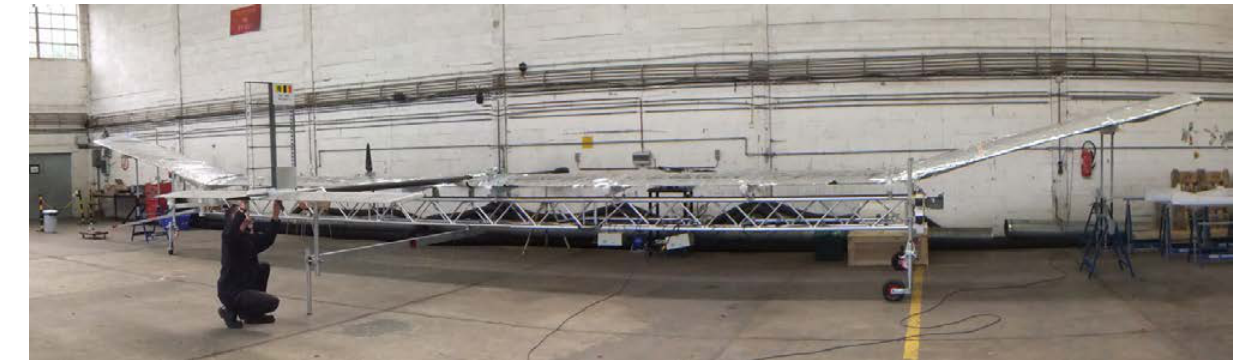
Table 1. Airspace Classification (CAP493, 2011)